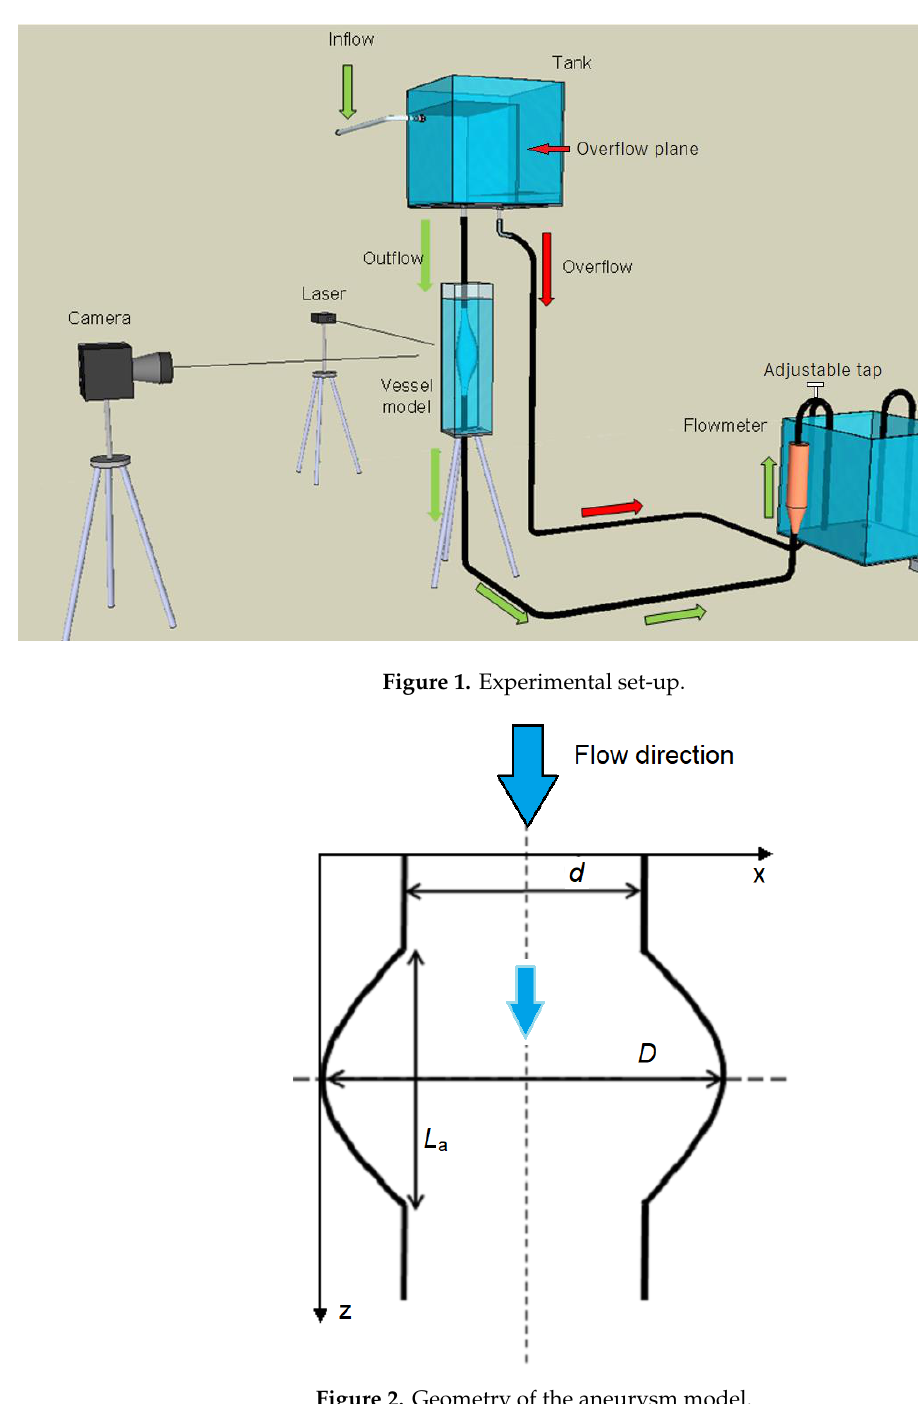
Figure 2. Geometry of the aneurysm model.